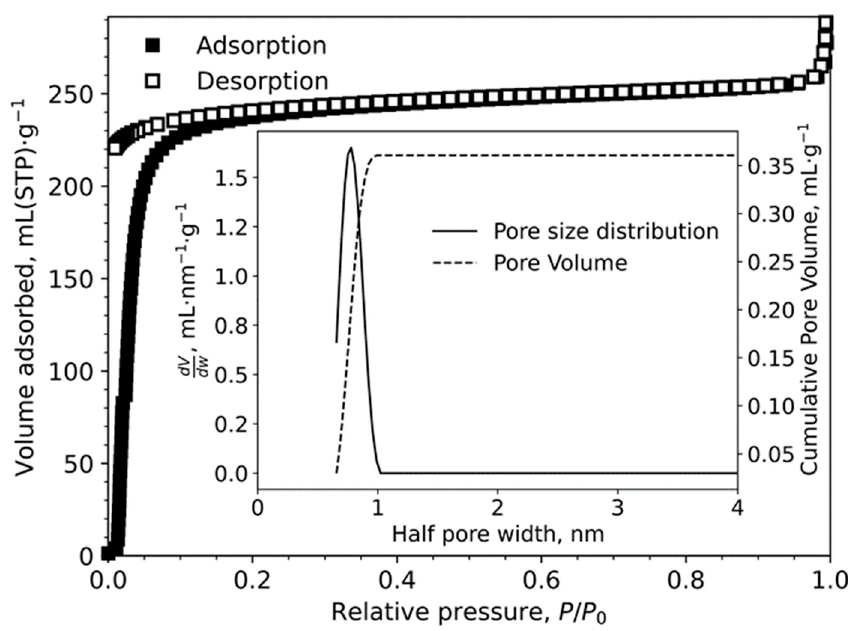
Figure 2. Nitrogen adsorption–desorption isotherms at 77 K and pore volume distribution (insert).